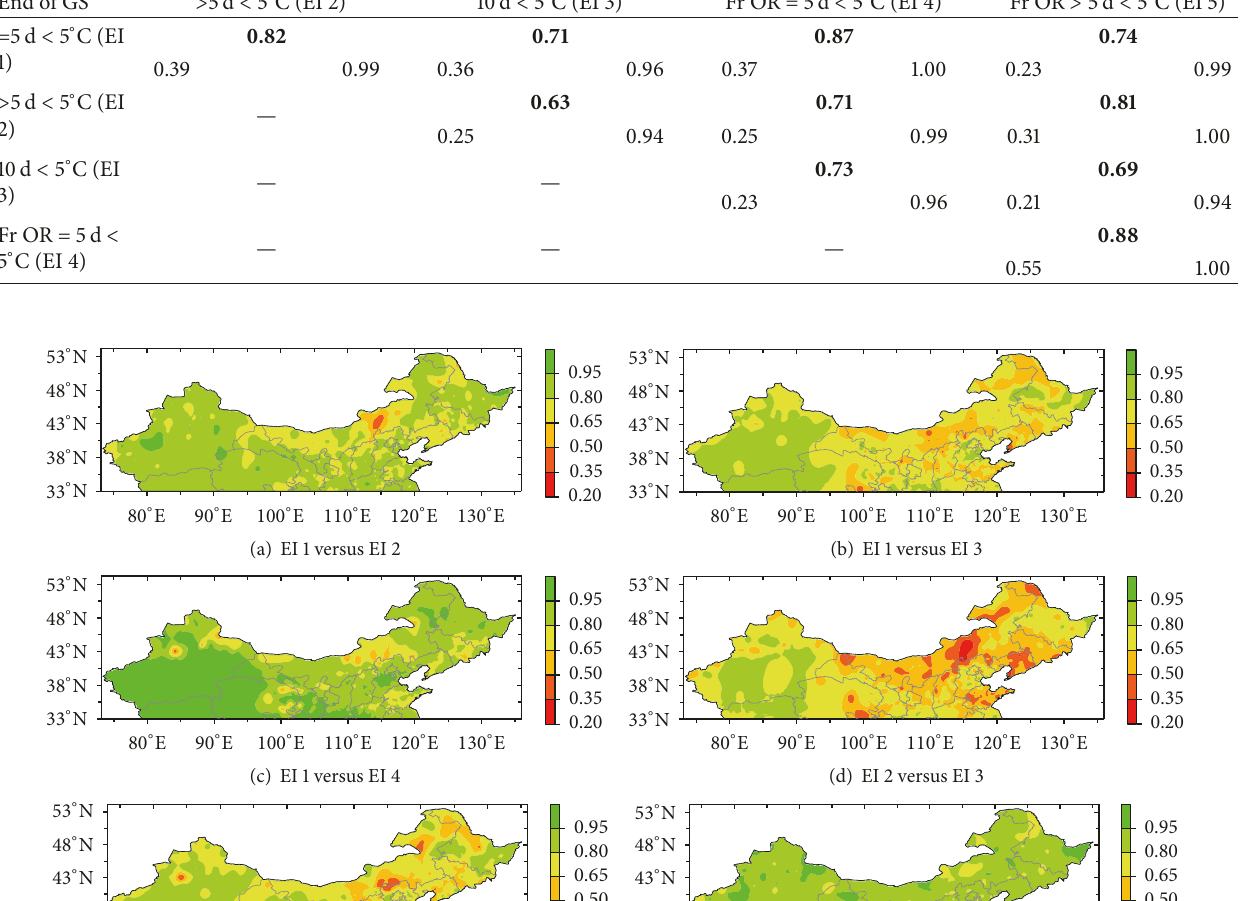
the 0.01 level in almost all areas of northern China. Stations with higher correlation coefficients among combinations of indices were mostly located in the western part of the study area, whereas in the eastern and northeastern part, there was no constant and strong relationship between different indices (Figure 4). Except for two stations (Abag Banner station and Bordered Yellow Banner station) in Inner Mongolia, the correlation coefficients for the combination of EI 1 and EI 2 were all over 0.50, and in most areas they ranged from 0.65 to 0.95, accounting for 92.5% of the total stations across northern China (Figure 4(a)). For the combination of EI 1 and EI 3, there were obvious differences in correlation coefficients between the western and the eastern regions. In the Inner Mongolia, Gansu, central and eastern Qinghai, and the east of above regions, 75.9% of the total stations had the corre- lation coefficients of 0.50–0.80, but in central and southern